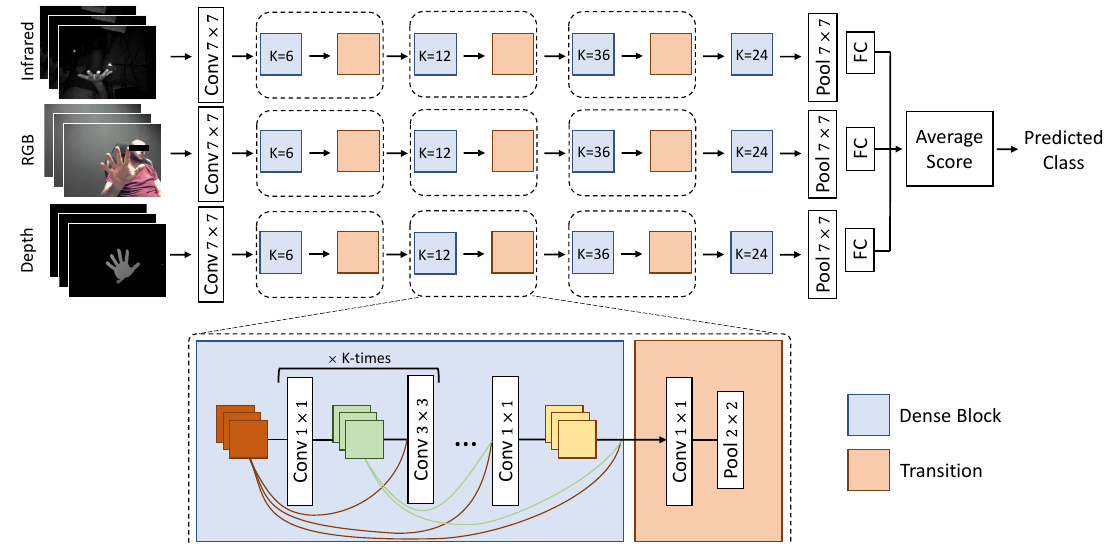
Figure 1. Overview of the proposed multimodal architecture using a triple input (infrared, RGB and depth streams). Each branch is composed of a modified version of the DenseNet-161 [22] architecture, which combines a sequence of dense and transition blocks. The input is a stream of images from different modalities and the predictions of the three networks are combined with a late-fusion approach to obtain the predicted